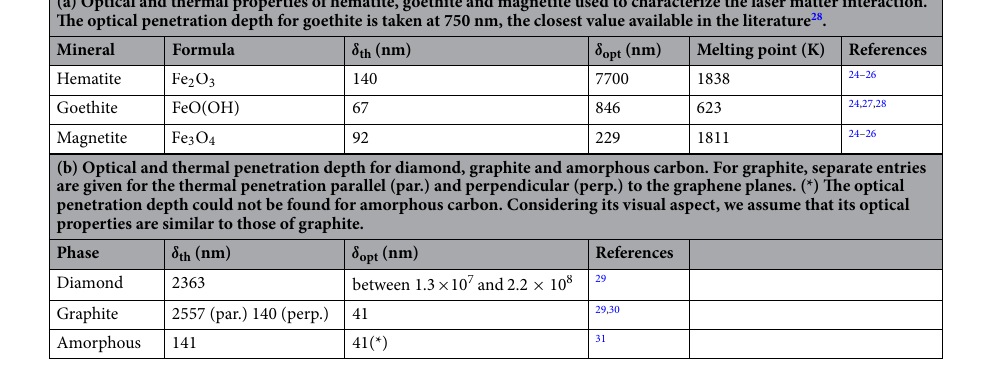
Table 1. Physical properties of the phases analyzed.